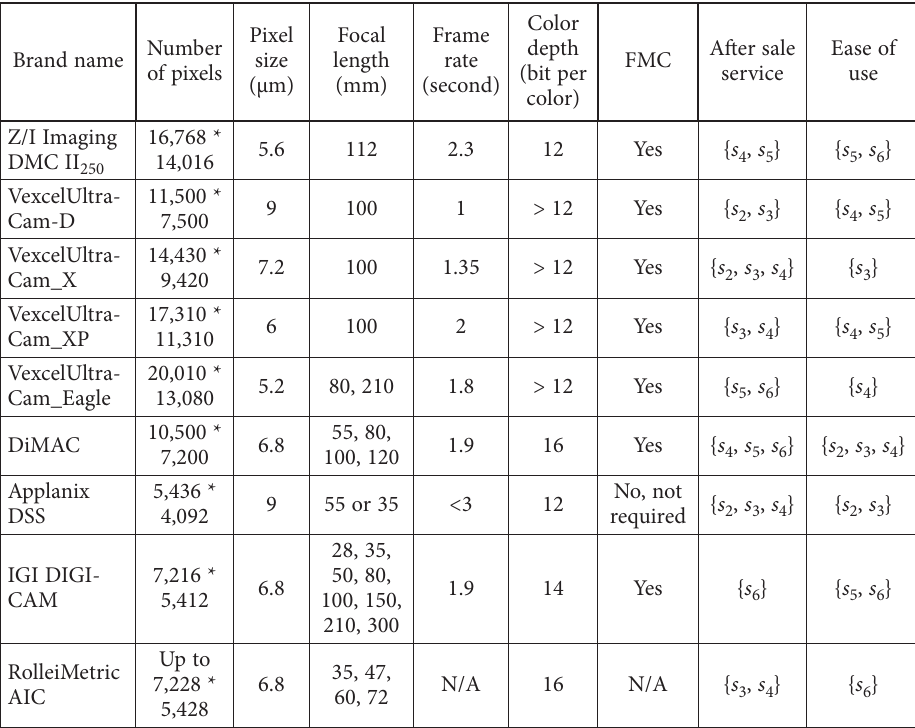
Table 6. Decision matrix of camera